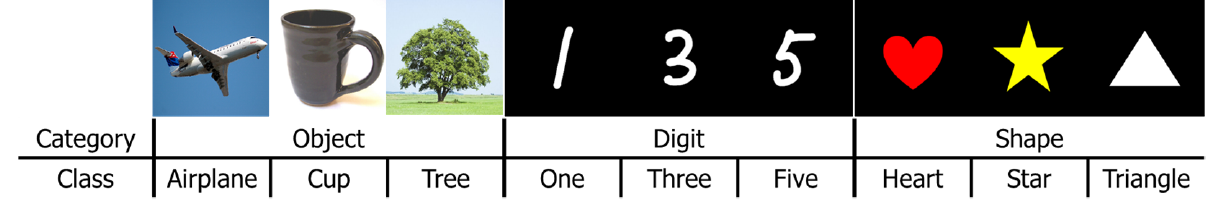
Figure 1. Images of 9 classes as visual stimuli.